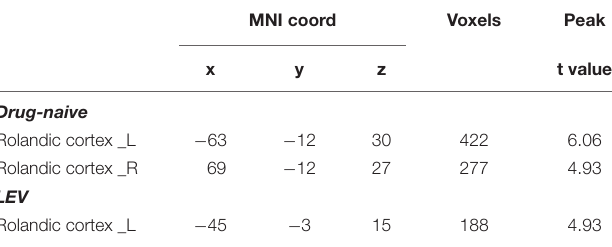
MNI coord Voxels